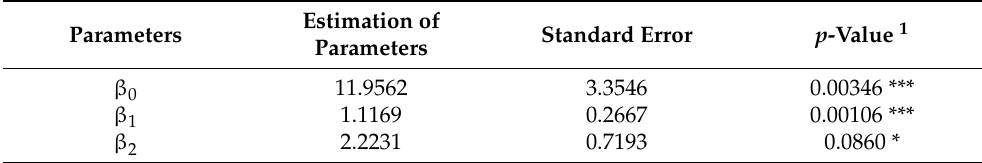
Table 2. Analysis results for the standard regression model (Formula (9)).